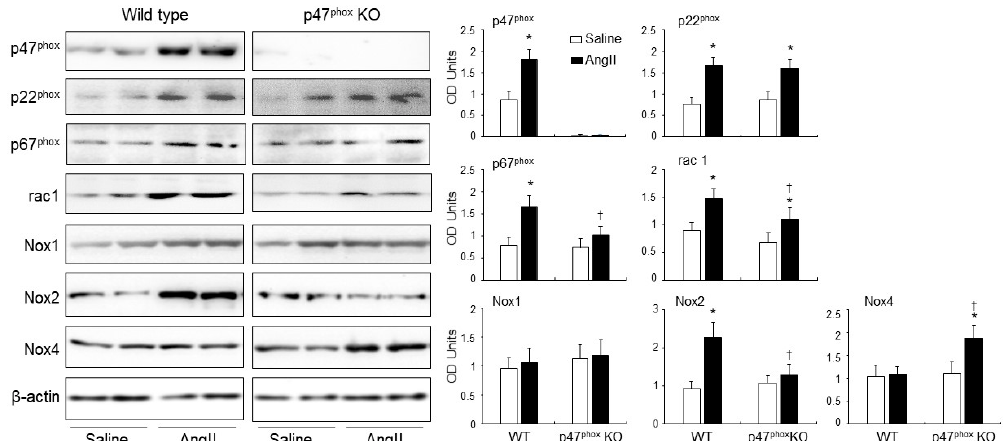
Figure 3. Expressions of isoforms of the catalytic subunit of Nox (i.e., Nox1. Nox2, Nox4) and other subunits of Nox (p47 phox , p22 phox , p67 phox and rac1) in murine hearts. Left panels: Representative Western blot images. β -actin detected in the same samples were used as loading controls. Right panels: Optical densities (OD) of Western blot bands were quantified and normalised to the levels of β -actin detected in the same samples. n = 9 per group. Statistical comparisons were made using two-way ANOVA. * p < 0.05 for AngII values versus saline values in the same genetic group; † p < 0.05 for p47 phox KO AngII values versus WT AngII values.